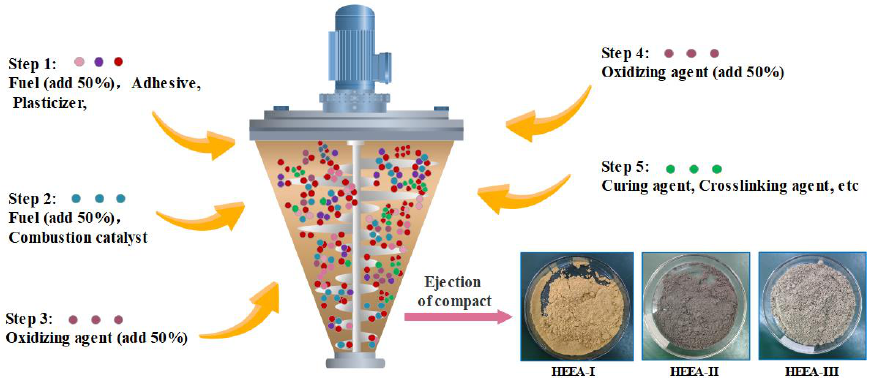
Figure 1. Schematic diagram of vertical screw mixer.